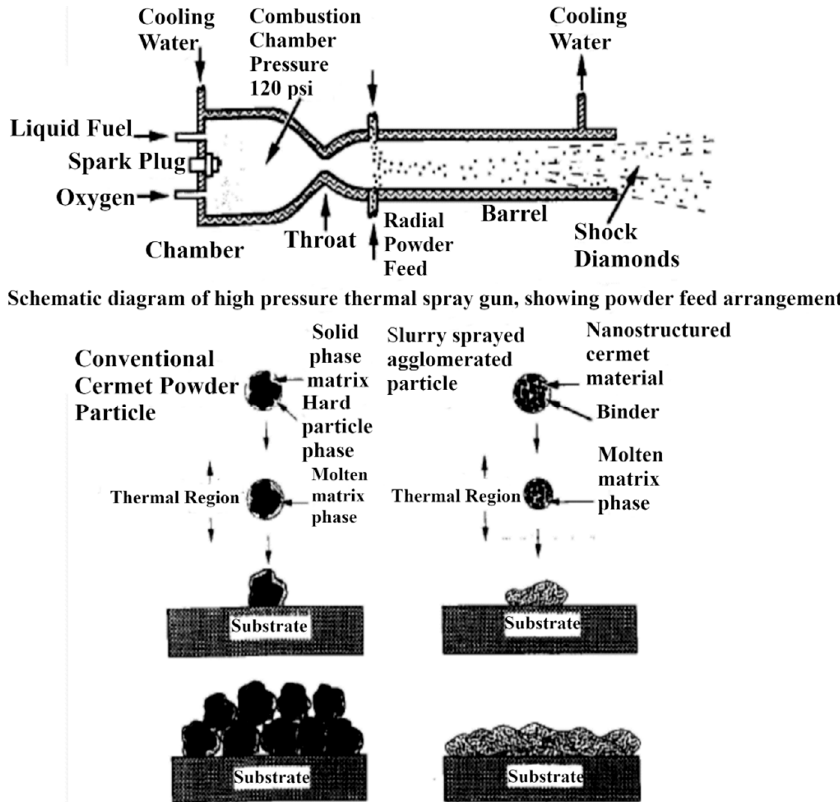
Figure 2. Comparison between thermal spraying of conventional and nanostructured powders [42]. Reprinted with permission from ref [42]. © 1995 Elsevier.